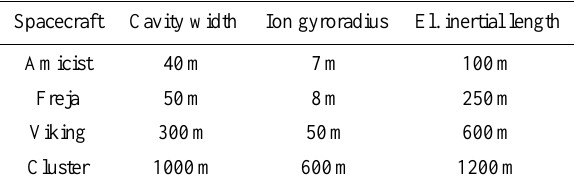
Table 2. The typical LHC widths determined by different space- craft. Some typical parameters relevant to the widths are